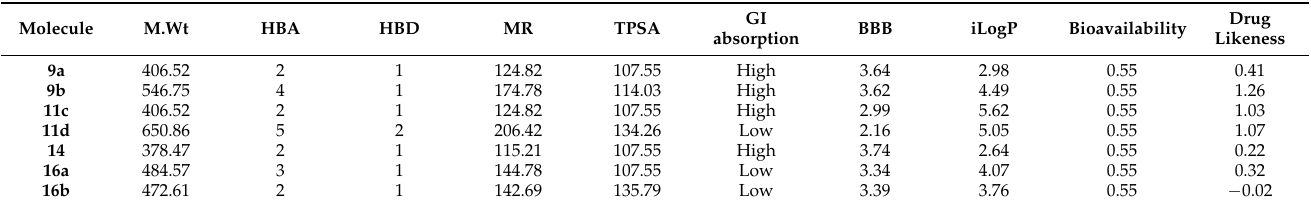
Table 2. Results of the in silico pharmacokinetics assessment of the tested